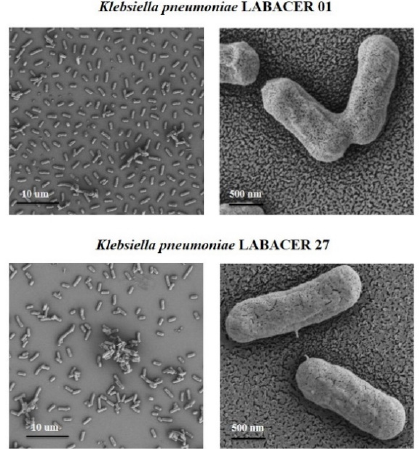
Figure 10. Scanning electron microscopy analysis of the KPC-2-producing hypermucoviscous ST25 Klebsiella pneumoniae strains LABACER 01 and LABACER 27.